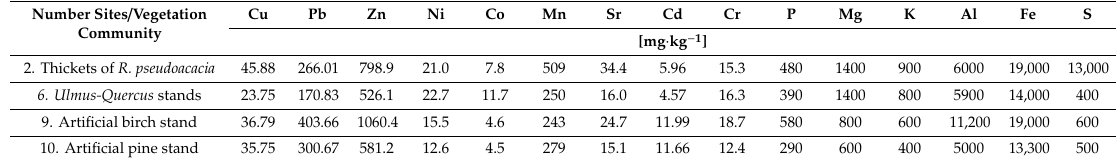
Table 6. The total contents of the selected heavy metal and macroselement for plant growth. Number Sites / Vegetation